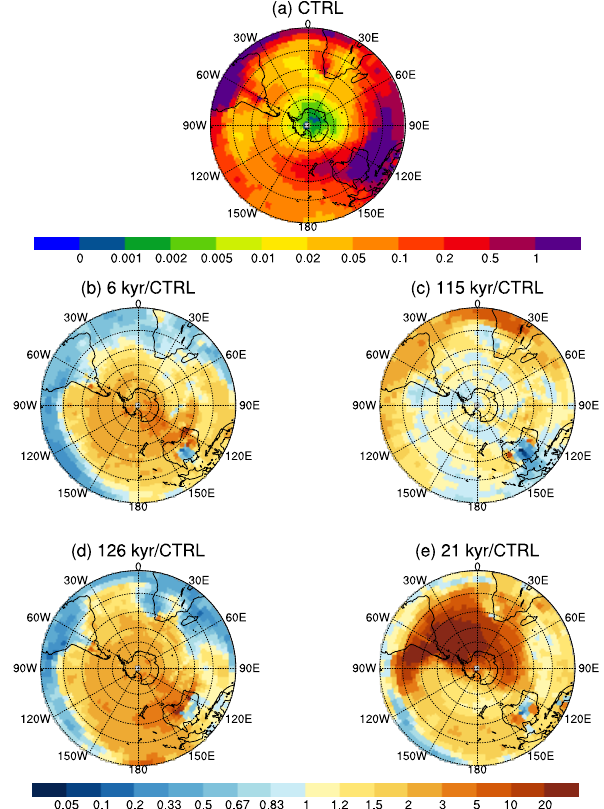
Figure 4. (a) Annual average dust deposition flux (gm − 2 yr − 1 ) for the Southern Hemisphere for the CTRL pre-industrial simulation. (b–e) Ratio of dust deposition flux for the interglacial and glacial time slices with respect to the CTRL pre-industrial